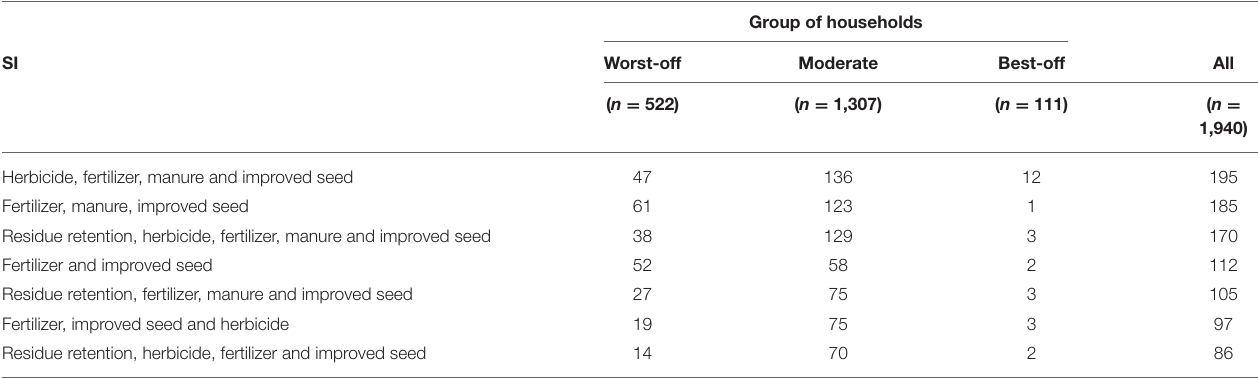
TABLE 4 | The number of households using management practices across target groups in Ethiopia. Sustainable intensification (SI) technologies in grey are excluded from further analysis.